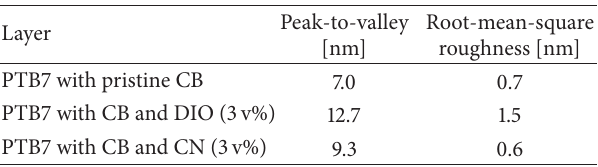
Table 3: Surface roughness parameters of the PC obtained from AFM